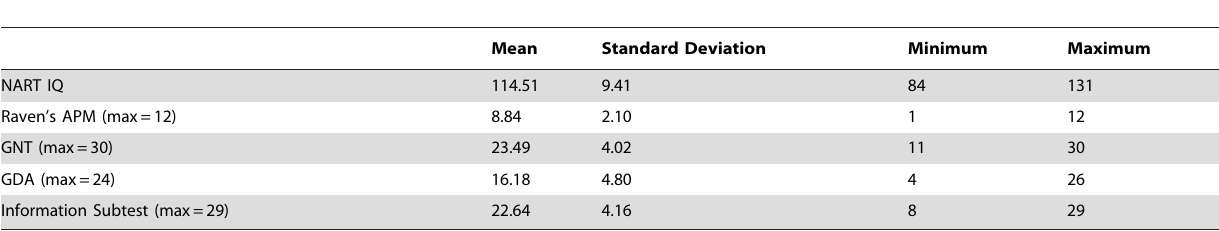
Table 2. Performance of the 184 healthy volunteers on the background neuropsychological measures.